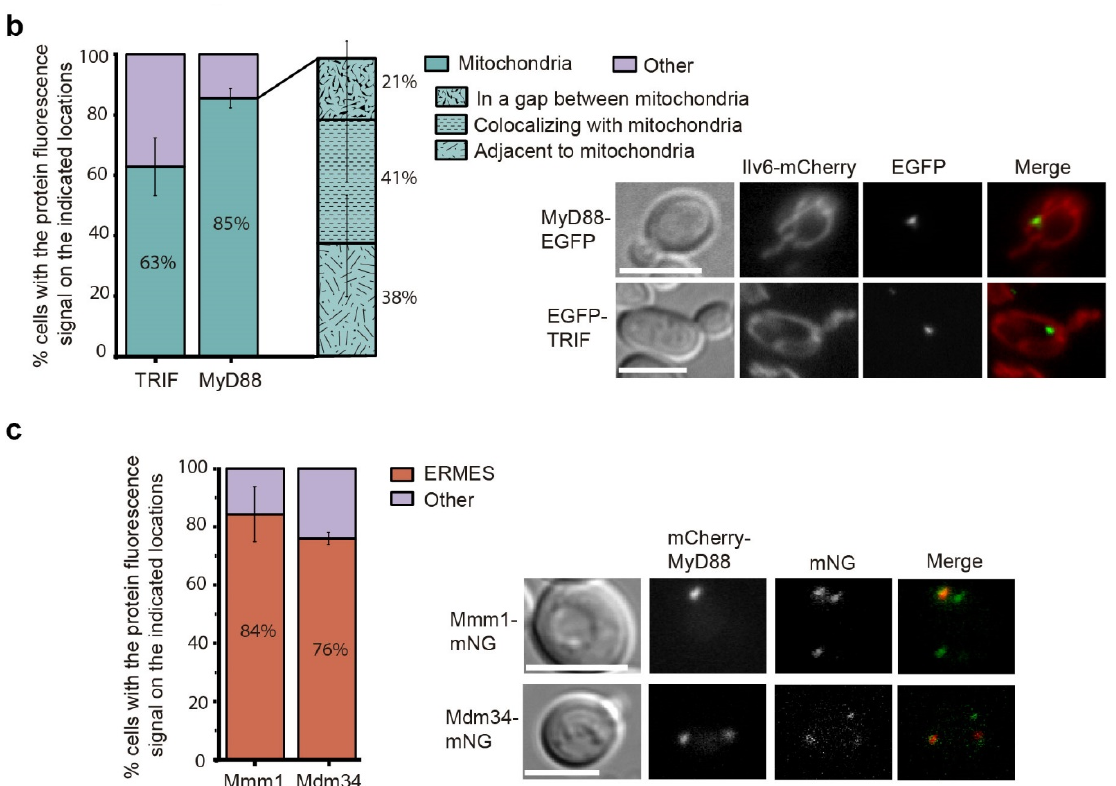
Figure 6. MyD88 is associated to ER-mitochondrial encounter structure (ERMES). ( a ) Differential interference contrast and fluorescence microscopy of yeast cells expressing MyD88-EGFP or EGFP-TRIF in the VHY87 strain, which bears the endoplasmic reticulum marker DsRed-HDEL (right), and graph (left) displaying the percentage of yeast cells showing MyD88-EGFP and EGFP-TRIF spots colocalizing with the indicated endoplasmic reticulum (ER) locations: cortical ER (cER), perinuclear ER (nER) or the link between both (L), as indicated by arrowheads in the image. Data correspond to means ± standard deviation of three independent transformants ( n > 90). ( b ) Differential interference contrast and fluorescence microscopy of yeast cells co-expressing MyD88-EGFP or EGFP-TRIF with the mitochondrial marker Ilv6-mCherry on the BY4741 trp1 Δ strain (right), and graph displaying the percentage of yeast cells showing the indicated relative positions between MyD88-EGFP and EGFP-TRIF, and the mitochondria (left). Data correspond to means ± standard deviation of three independent transformants ( n > 90). ( c ) Differential interference contrast and fluorescence microscopy of yeast cells expressing mCherry-MyD88 in the EVY4 and EVY5 strains, that bear the ERMES components Mdm34 and Mmm1, respectively, tagged with mNeonGreen (right). Graph displaying the percentage of cells showing colocalization between MyD88 and each marker (left). Data correspond to means ± standard deviation of three independent transformants ( n > 150).